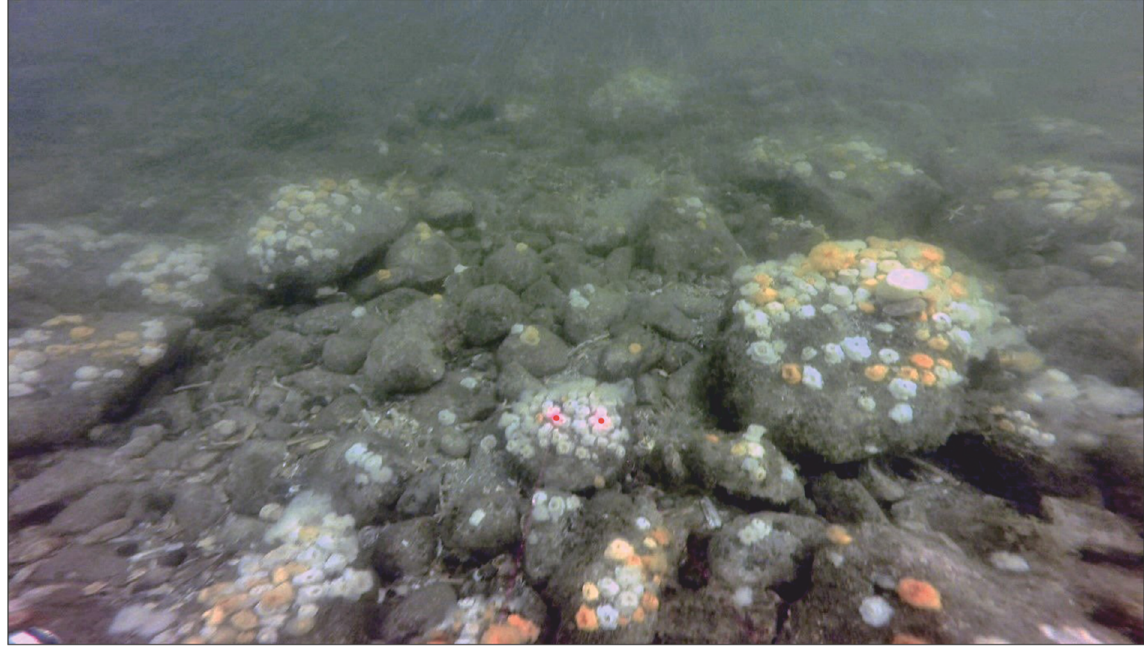
Figure 6. Representative image from the rocky reef. Red markers in the centre of the image are spaced 10 cm apart from each other.